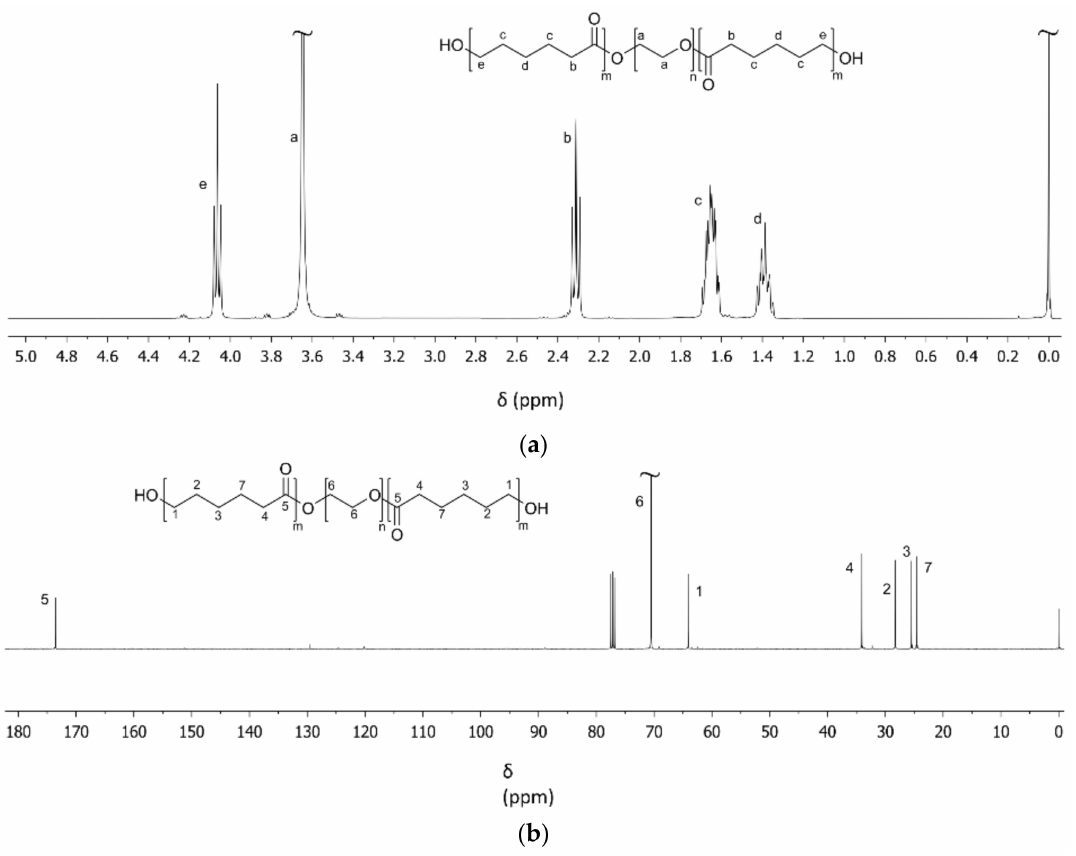
Figure 2. Characteristic ( a ) 1 H-NMR and ( b ) 13 C-NMR spectra of PCL 5 -PEG 10 -PCL 5 triblock copolymers after purification by